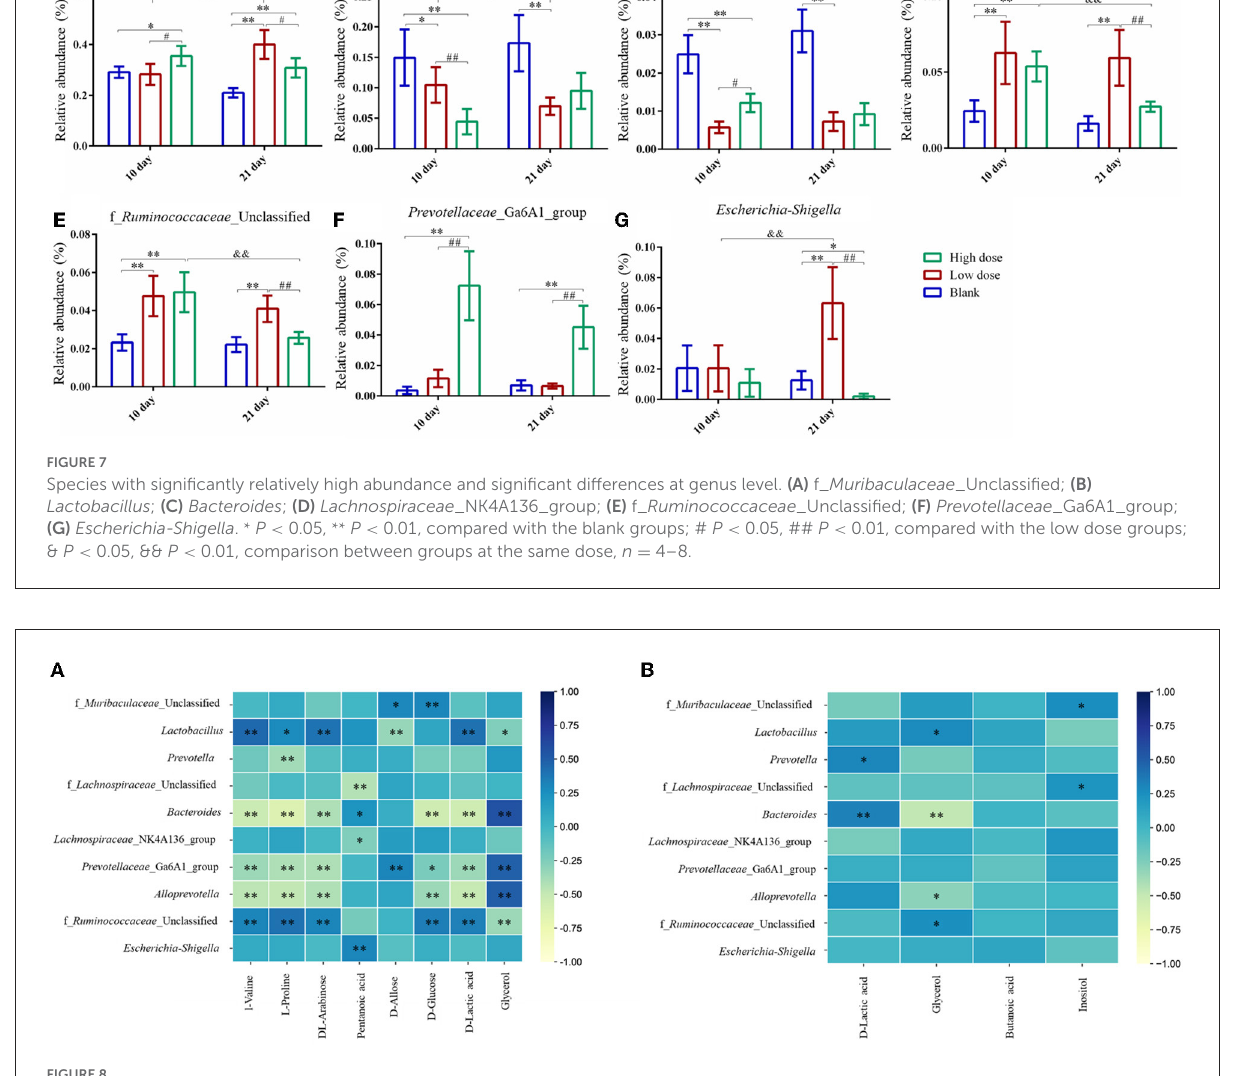
FIGURE8 Heatmaps of correlation analysis between top 10 abundance species at genus level and urine (A) or fecal (B) metabolites. * P < 0.05; ** P <